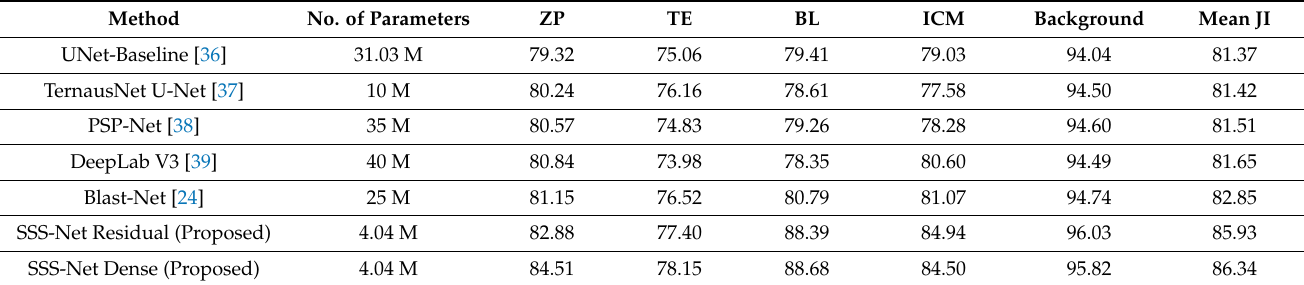
Table 2. Numerical Comparison of Proposed SSS-Net with the State-of-the-Art